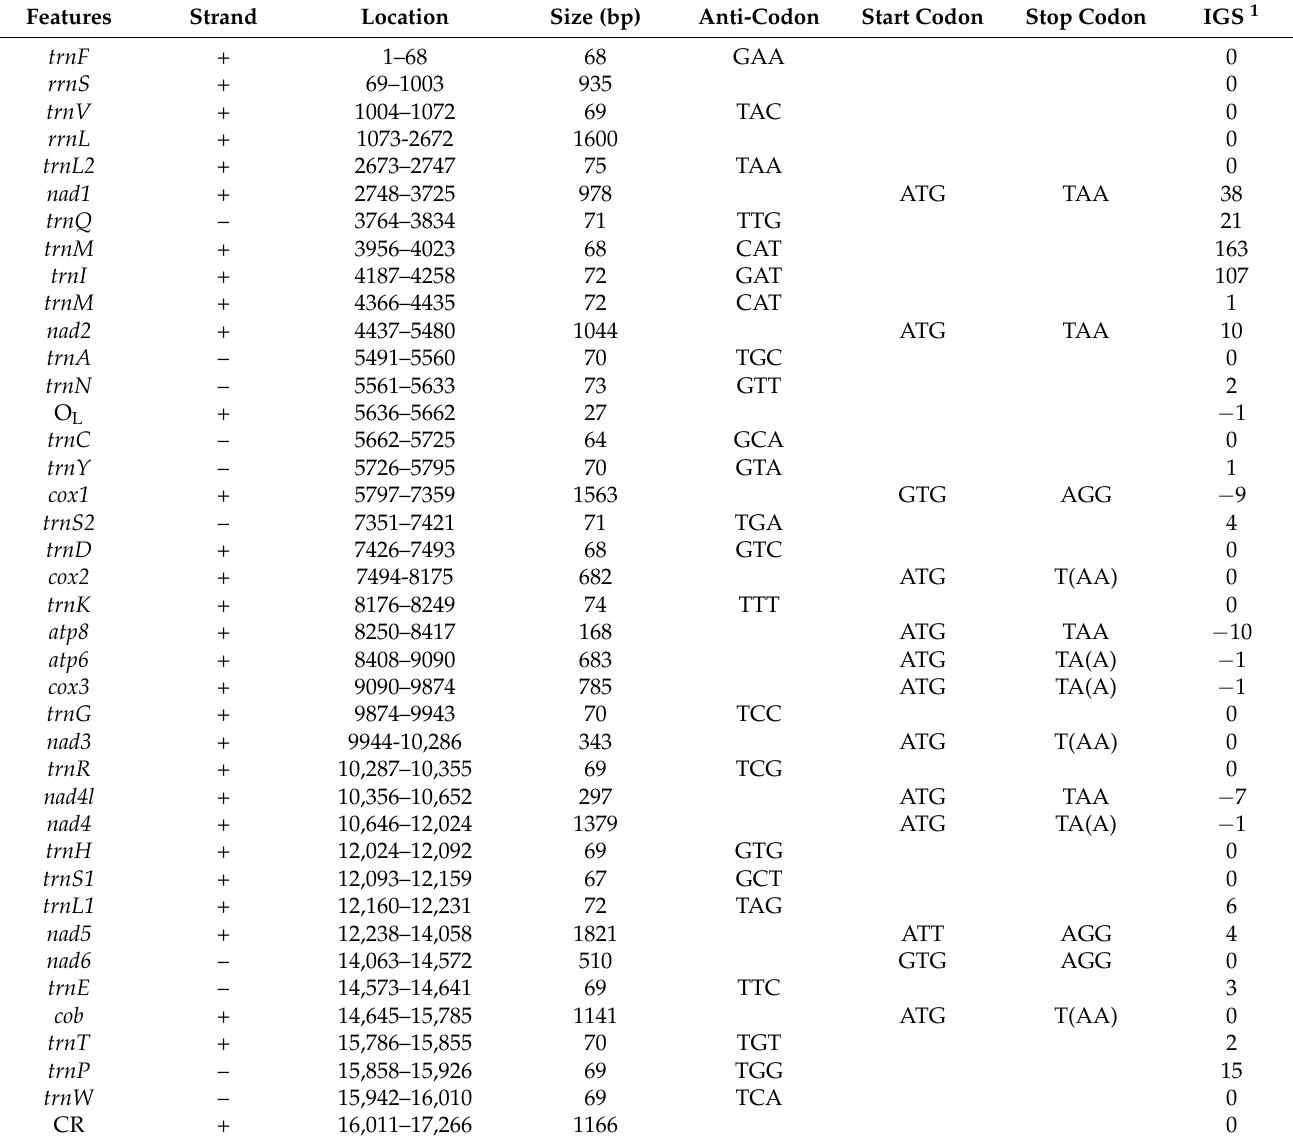
Table 1. The mitogenome organization of Oreolalax omeimontis